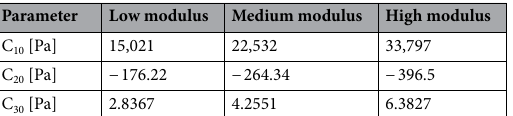
Table 2. Hyperelastic fitting parameters for optically clear adhesives at low-, medium-, and high-modulus values.